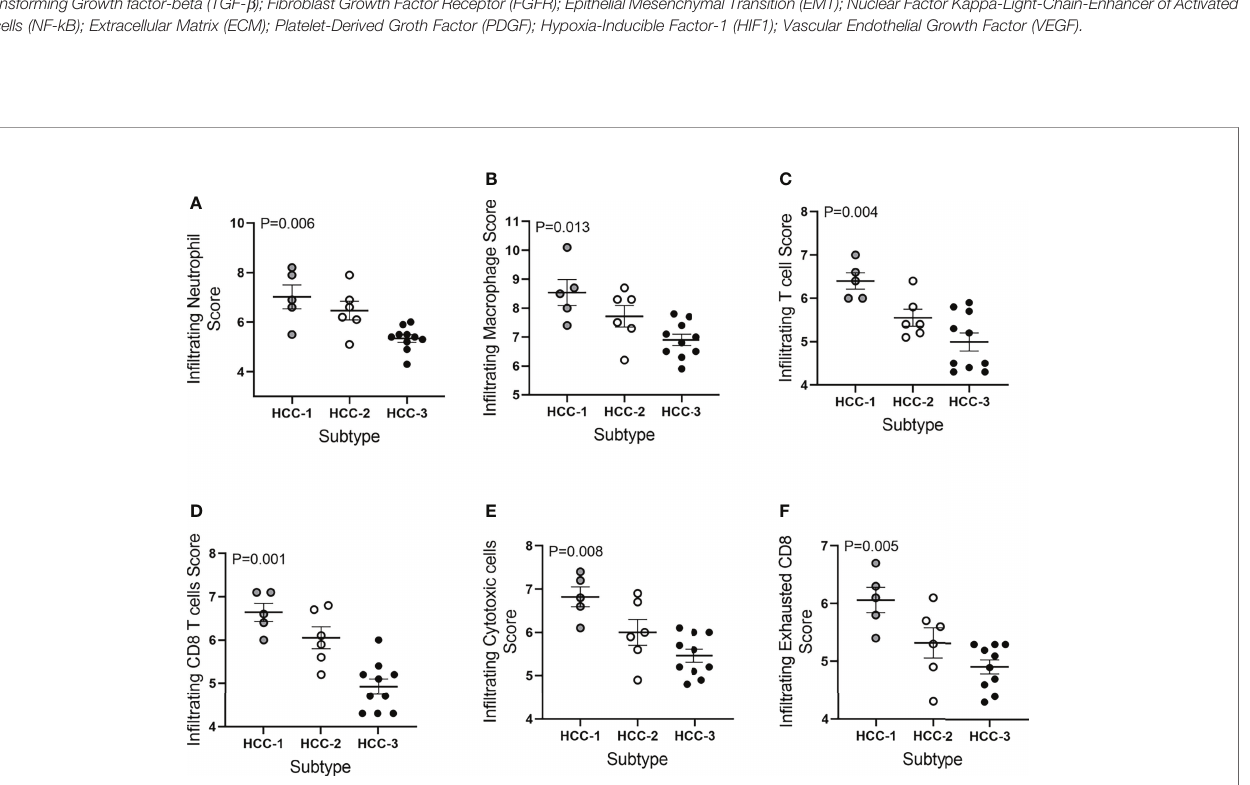
FIGURE 2 | Immune cell type pro fi ling score of HCC tumors based on subtype. In fi ltrating immune cell type scores included (A) neutrophils, (B) macrophages, (C) T cells, (D) CD8 T cells, (E) cytotoxic cells, and (F) exhausted CD8 T cells. Abundance was determined using log2 normalized mRNA counts for each speci fi c cell type marker and subtracting the total TIL score (average B cell, T cell, CD45, macrophage, and cytotoxic cell